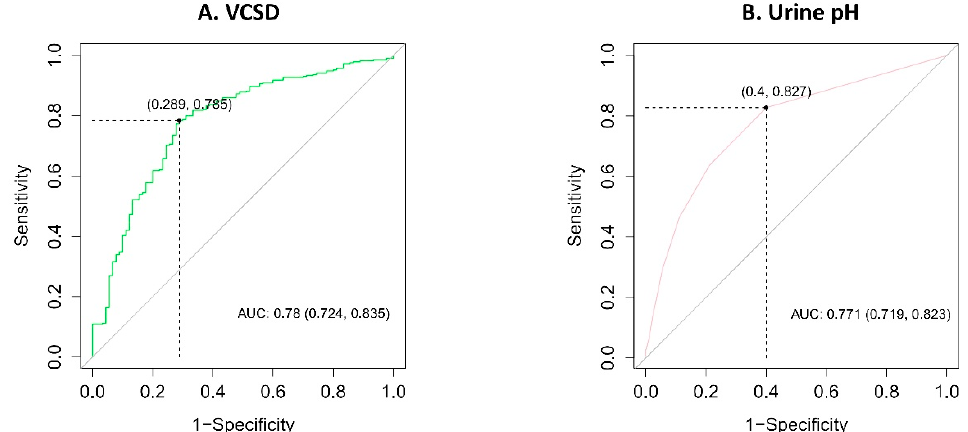
Figure 4. Receiver operating characteristic (ROC) curve of uric acid stones for ( A ) variant coefficient of stone density (VCSD), AUC = 0.780 (95% confidence interval [CI]: 0.724–0.835), cutpoint of 25.67; ( B ) urinary pH, AUC = 0.771 (95% CI: 0.719–0.823), cutpoint of 5.5. AUC, area under ROC curve. For MSD, the area under the ROC curve (AUC) was 0.782 (95% confidence interval [CI]: 0.732– 0.833), with a cutpoint of 572.3 HU, a sensitivity of 0.697 (95% CI: 0.644–0.746), a specificity of 0.855 (95% CI: 0.766–0.921), a positive predictive value of 0.946 (95% CI: 0.907–0.958), and a negative